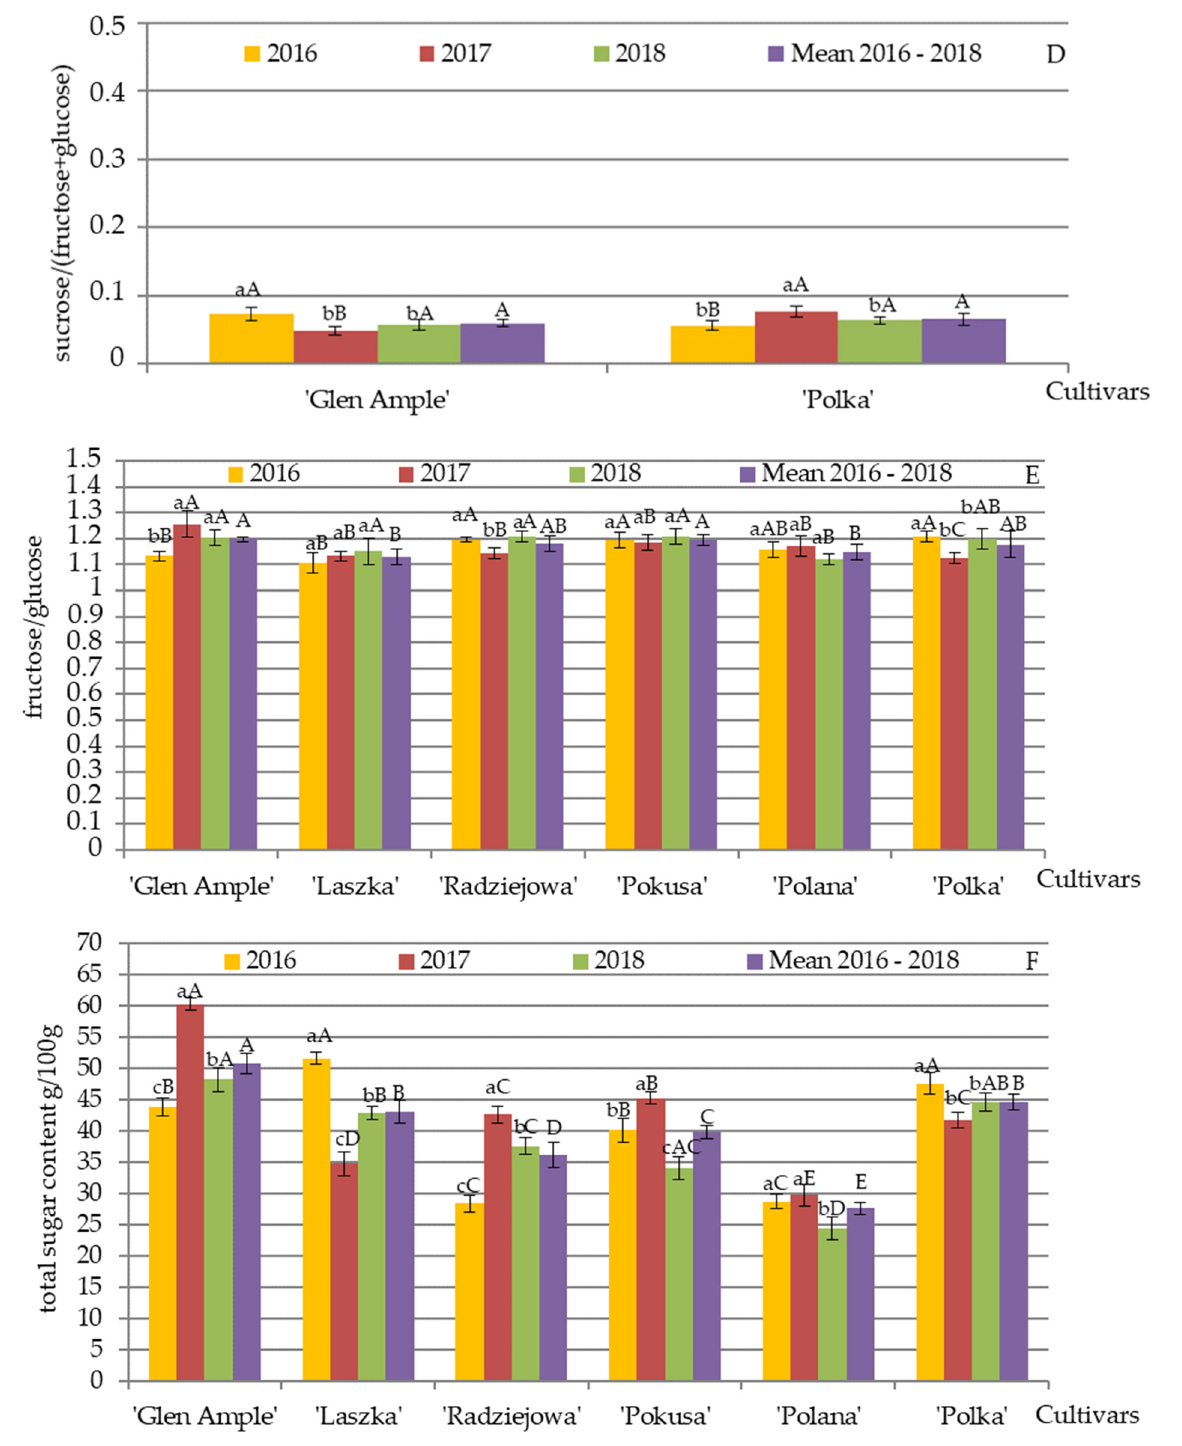
Figure 2. ( A – F ). Qualitative and quantitative composition of the nectar of the six R. idaeus cultivars analyzed in the three study years. Explanations: means followed by the same small letter are not signifi- cantly different within the cultivar in the years, and means followed by the same capital letter do not differ between the cultivars in each year of the study at a significance level α = 0.05 (two-way ANOVA, Tukey’s test).